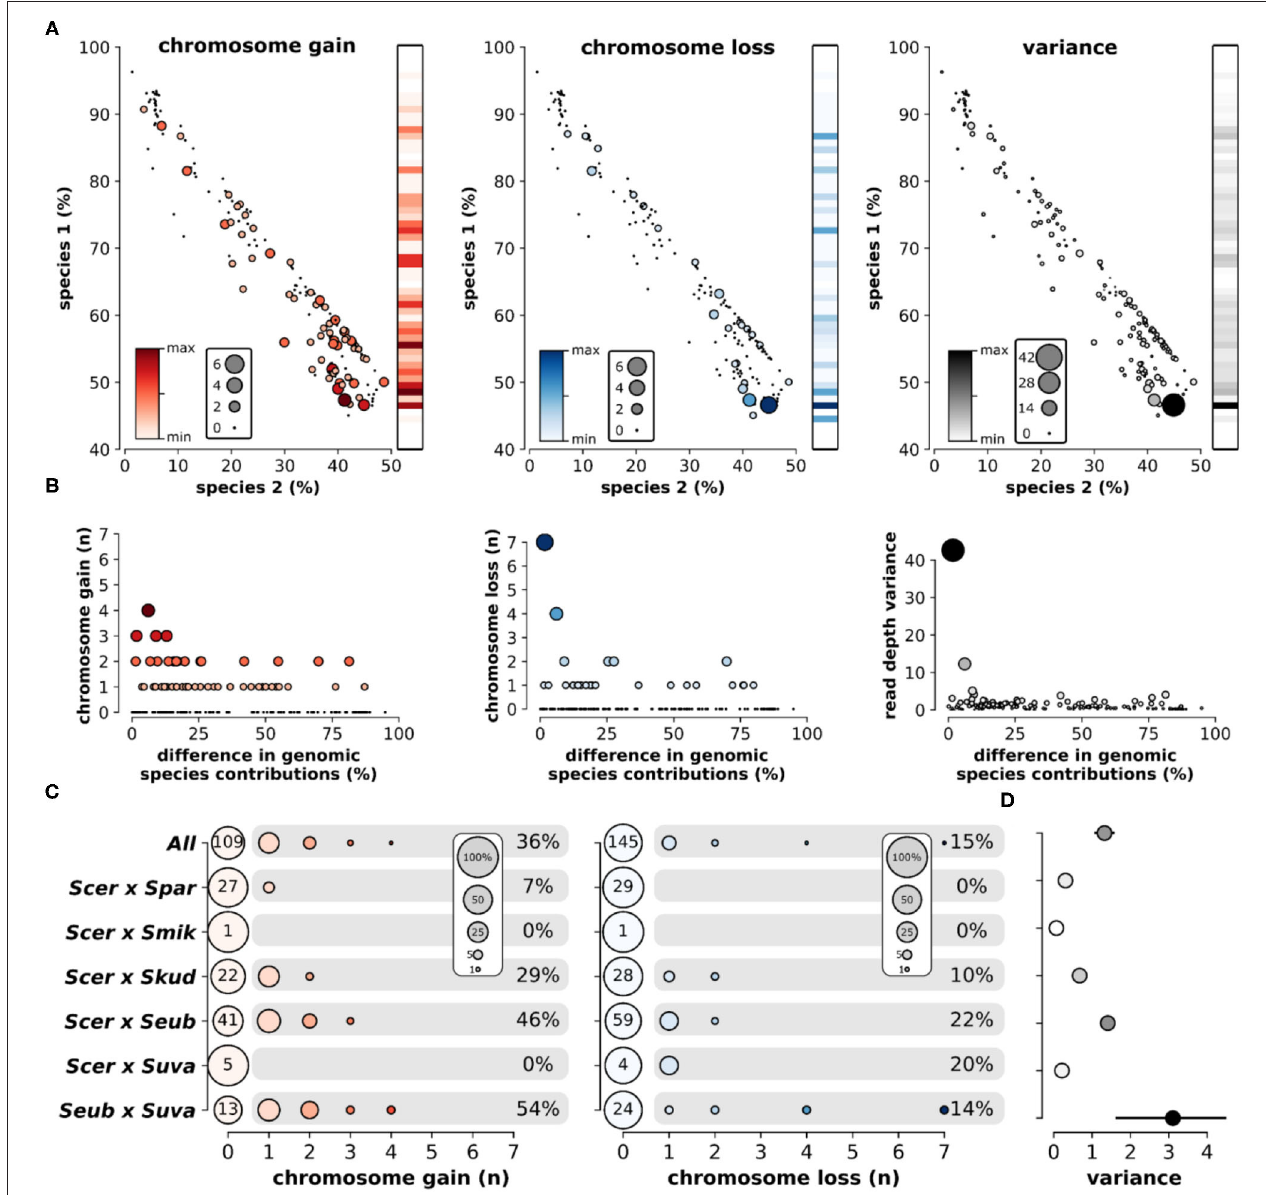
FIGURE 6 | Aneuploidy and sequencing read depth variance among hybrid crosses. (A) The relationship of percent reads mapping to species 1 and species 2 and the number of chromosomes gained (red), chromosomes lost (blue), and read depth variance (black). Color and size of nodes indicate the number of chromosomes or read depth variance. Heatmaps indicate the mean level gain, loss, or variance for each level of species 1 inheritance. (B) Relationship between the difference in genomic contributions from each species (sp1-sp2) and aneuploidy. Color and size of nodes indicate the number of chromosomes or read depth variance. (C) The number of chromosomes gained or lost in each hybrid cross. Node size indicates the percentage of genomes within each hybrid cross. Numbers at point zero indicate the number of genomes without a gain or loss. Percentages indicate the proportion of genomes within that hybrid cross with at least one chromosome gain or loss. (D) The mean and standard error of chromosome read depth variance for each hybrid